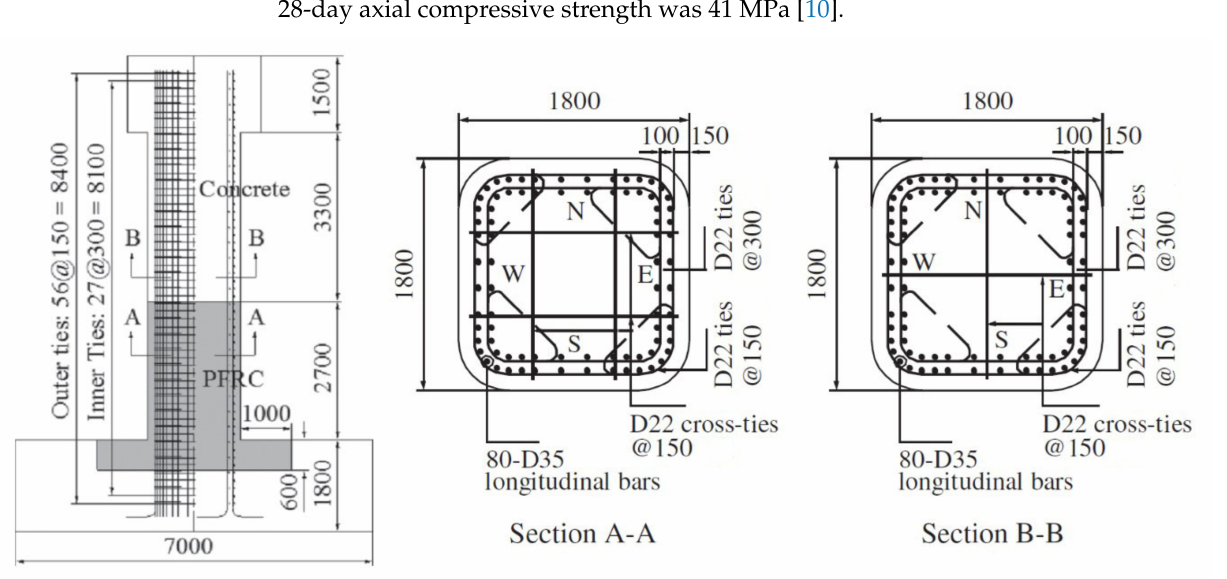
Figure 1. Dimension and configuration of C1-6 (mm). Table 1. Mix proportion of ECC